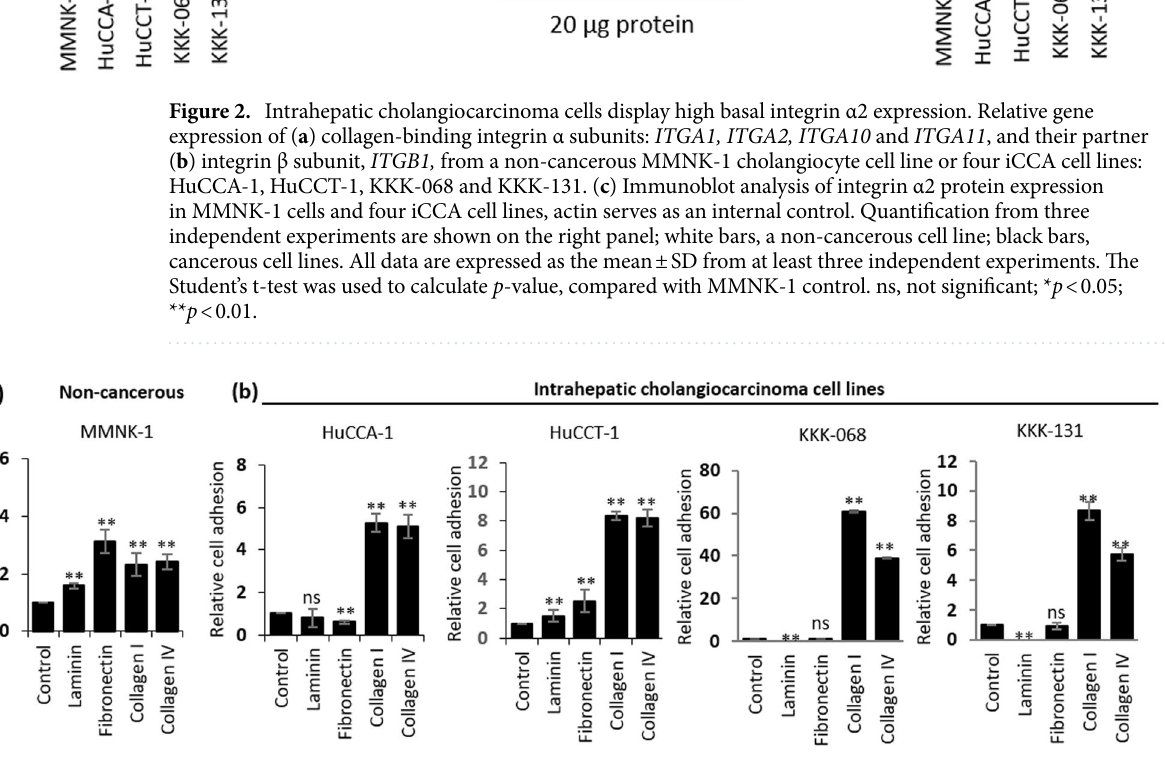
Figure 3. Intrahepatic cholangiocarcinoma cells display strong adhesion to collagen type I. ( a ) MMNK-1 cells or ( b ) four cancerous iCCA cell lines (HuCCA-1, HuCCT-1, KKK-068 and KKK-131) in a cell adhesion assay on uncoated control or indicated extracellular matrices at concentrations of 10 µg/mL for 1 h. The bar graphs represent the mean ± SD from at least three independent experiments. The Student’s t-test was used to calculate p -value, compared with a control group. ns, not significant; * p < 0.05; ** p <